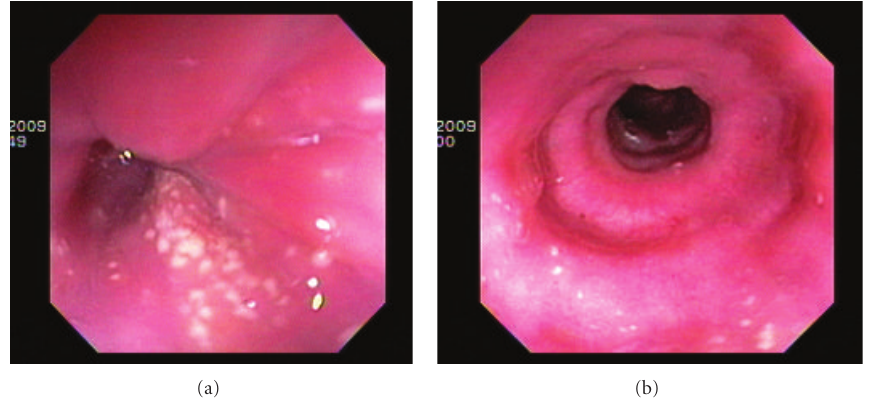
Figure 1: EGD showing di ff use pin-point whitish exudates and ringed.